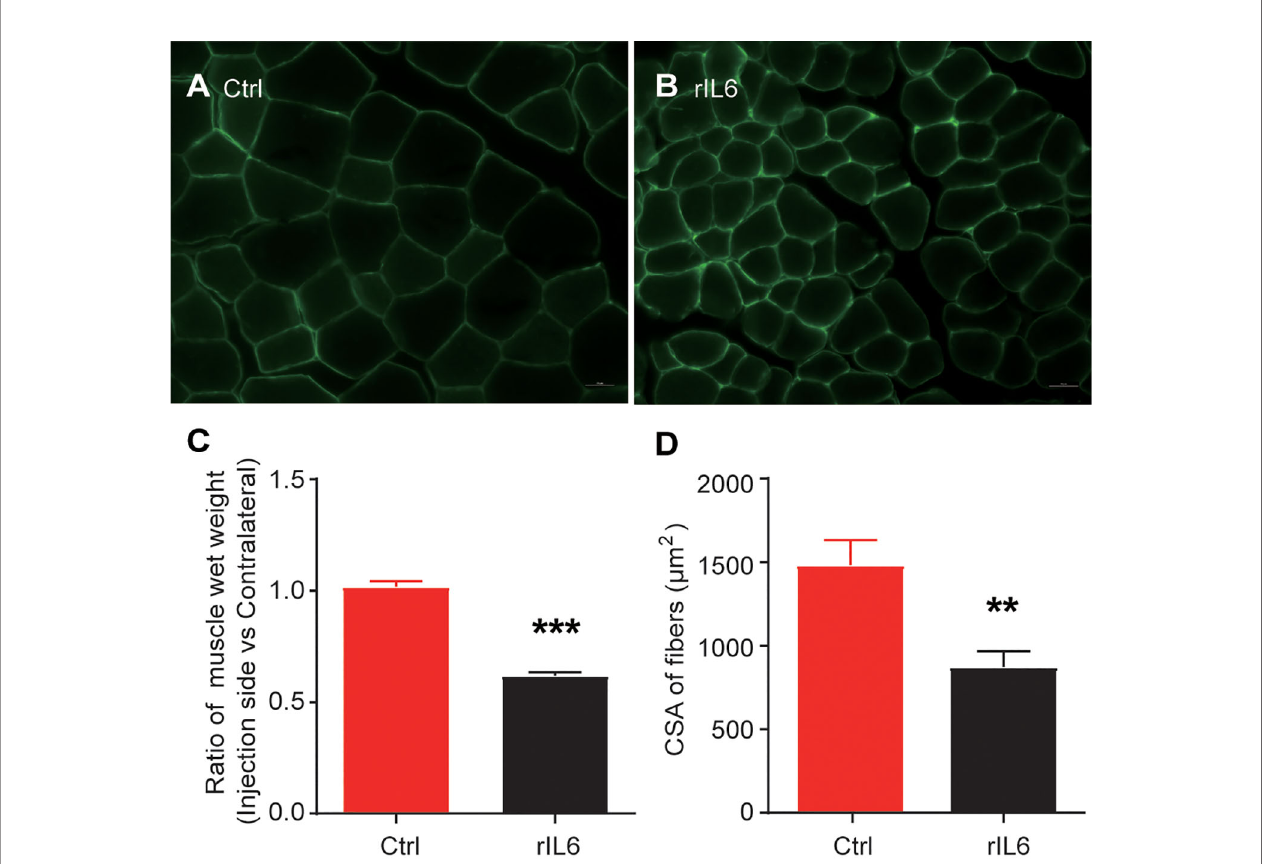
FIGURE 1 | Interleukin-6 (IL-6) induces skeletal muscle atrophy. (A) Laminin immunohistochemical staining of the tibialis anterior muscle of mice in the control group (injected with phosphate-buffered saline); scale bars = 20 m m. (B) Laminin immunohistochemical staining of the tibialis anterior muscle. (C) Results of the skeletal muscle wet-weight ratio between the experimental group and the control group. (D) Results of the comparison of the cross-sectional muscle fi ber area between the experimental group and the control group. Statistical results, the bar graph represents the mean ± standard error of the mean, T-test was used to calculate the P-values, n = 3, **P < 0.01, ***P < 0.001, experimental group vs. control group. CSA, cross-sectional area; Ctrl, control; IL-6, interleukin-6; rIL-6, recombinant